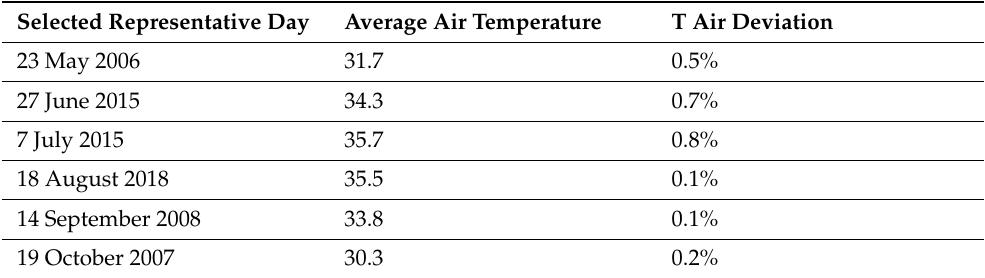
Table 2. Selected representative days in summer in Bahrain, with air temperature (T air) deviations from monitored long-term median